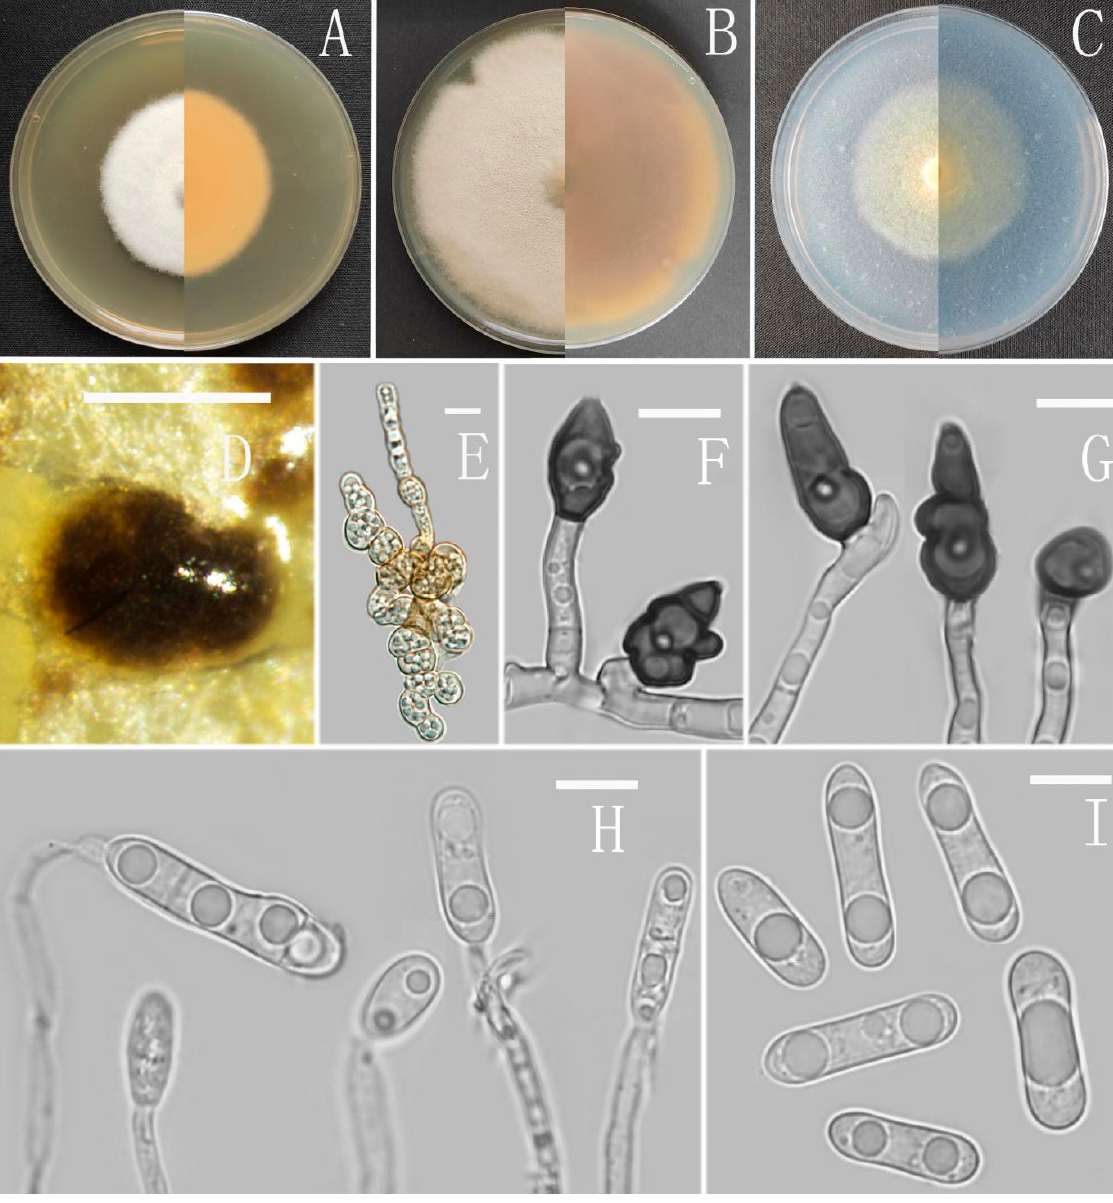
Figure 3. Colletotrichum analogum (YMF 1.06943). ( A – C ) Colonies on media above and below after 7 days at 25 °C (( A ) MEA; ( B ) PDA; ( C ) SNA). ( D ) Conidiomata. ( E ) Chlamydospores. ( F – G ) Appres- soria. ( H ) Conidiophores. ( I ) Conidia. Scale bars: ( D ) = 100 μ m, ( E – I ) = 10 μ m.